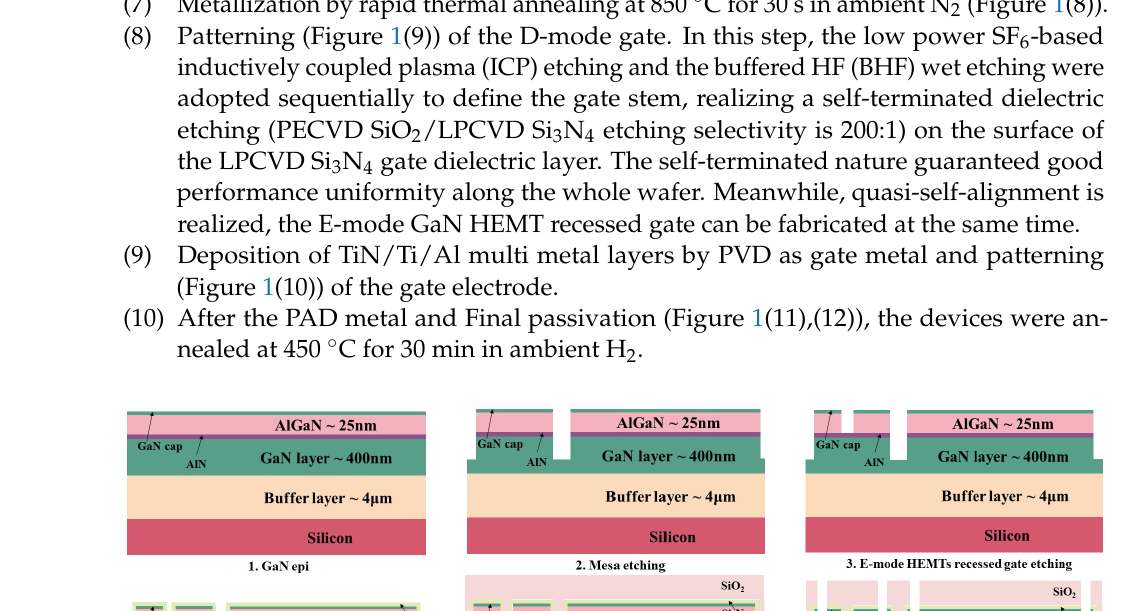
Metallization by rapid thermal annealing at 850 ◦ C for 30 s in ambient N 2 (Figure 1(8)). (8) Patterning (Figure 1(9)) of the D-mode gate. In this step, the low power SF 6 -based inductively coupled plasma (ICP) etching and the buffered HF (BHF) wet etching were adopted sequentially to define the gate stem, realizing a self-terminated dielectric etching (PECVD SiO 2 /LPCVD Si 3 N 4 etching selectivity is 200:1) on the surface of the LPCVD Si 3 N 4 gate dielectric layer. The self-terminated nature guaranteed good performance uniformity along the whole wafer. Meanwhile, quasi-self-alignment is realized, the E-mode GaN HEMT recessed gate can be fabricated at the same time. Deposition of TiN/Ti/Al multi metal layers by PVD as gate metal and patterning (Figure 1(10)) of the gate electrode. (10) After the PAD metal and Final passivation (Figure 1(11),(12)), the devices were an- nealed at 450 ◦ C for 30 min in ambient H 2 .